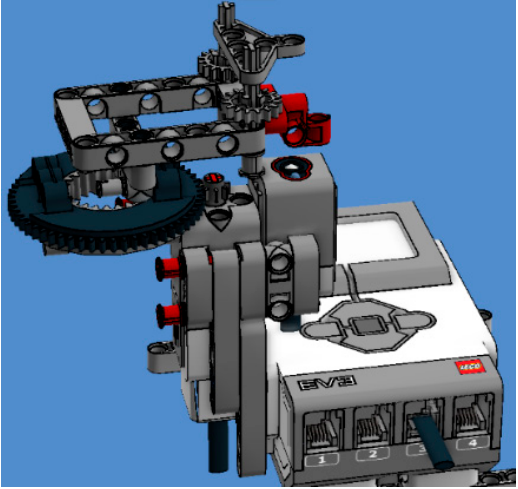
Figure 1. Design of the “orienting” device or semi-automatic data collection system. The BLE dongle and the USB cable that connects it to the laptop are not shown in the figure.